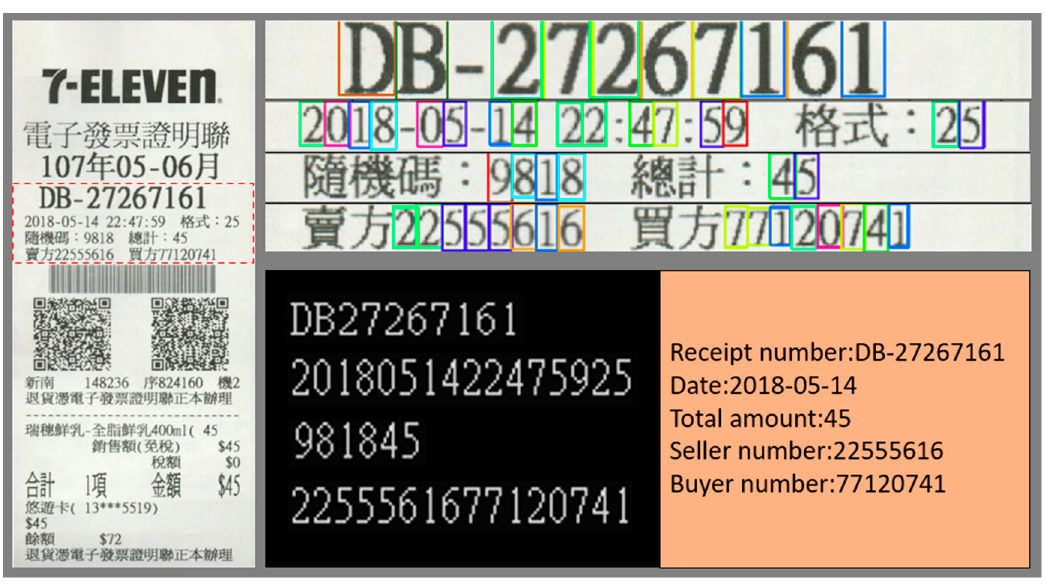
Figure 19. Recognition results of the printed receipts .